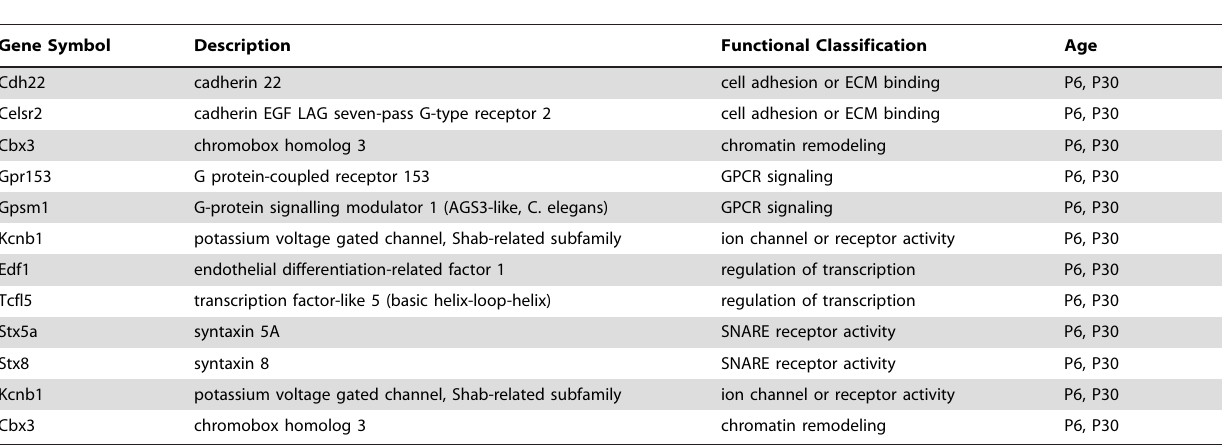
Table 7. Genes with abundant Bergmann glial expression (at both P6 and P30) that were not previously known to be present in